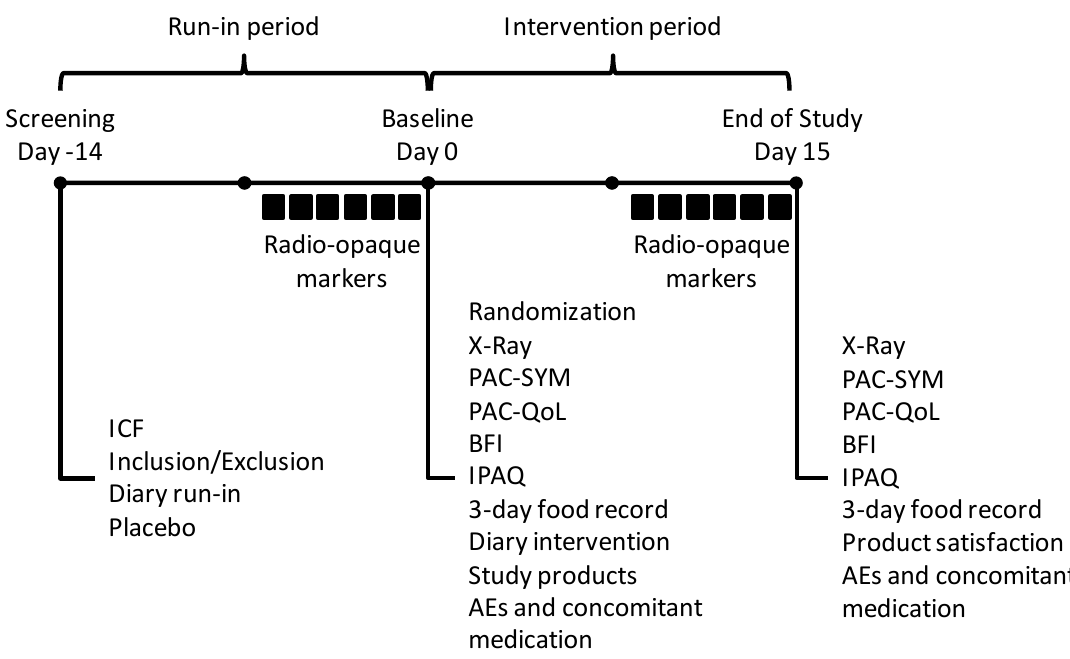
Figure 1. The study setup. AEs—adverse events; BFI—bowel function index; ICF—informed consent form; IPAQ—international physical activity questionnaire; PAC-SYM—patient assessment of constipation symptoms; PAC-QoL—patient assessment of constipation quality of life. (cid:4) , radio-opaque markers were consumed at the study site from Day -6 to Day -1 during the run-in period and from Day 9 to Day 14 during the intervention